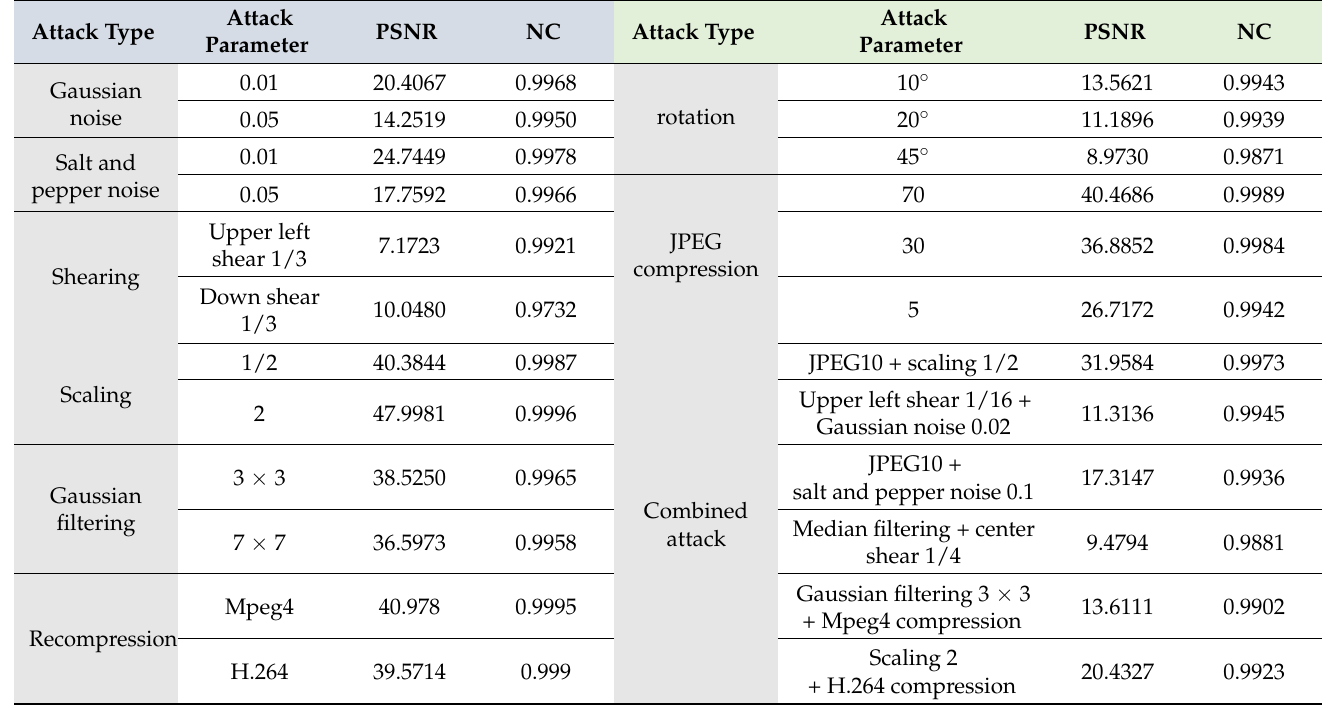
Table 3. Robustness experimental results of the